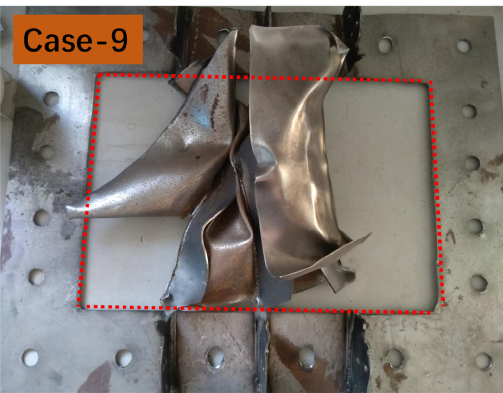
Figure 19. Tearing failure along the edges in Test No. 9.